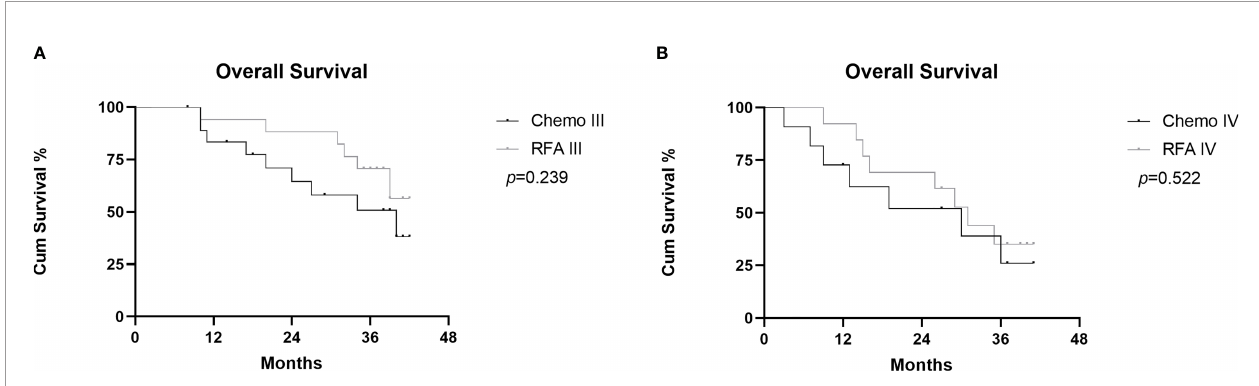
FIGURE 5 | Graphs show subgroup analysis of cumulative OS between RFA group and chemo group in FIGO III stage patients (A) and FIGO IV stage patients (B)